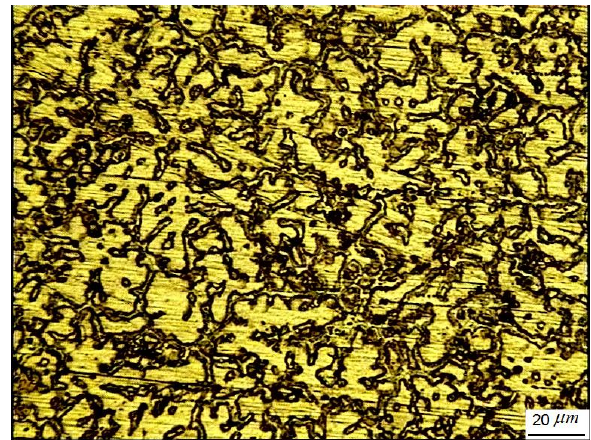
Figure 11: Optical microscope image of as-cast AZ30 at strain of 0.3 and temperature of 493 K and forming rate of 0.00025 s –1 .